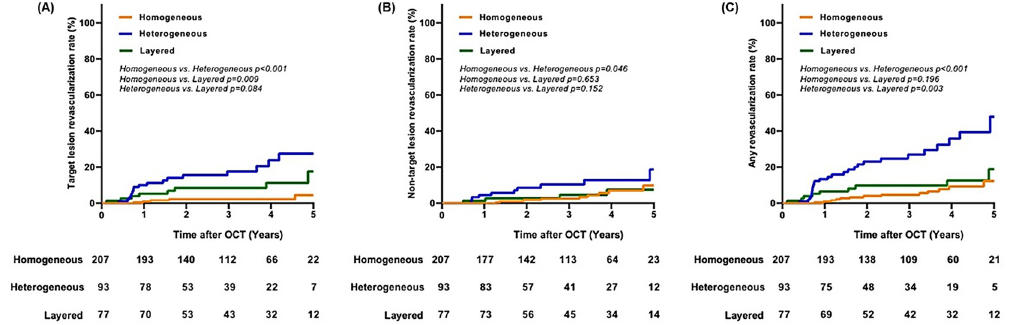
Fig 1. Kaplan-Meier curves for the target lesion revascularization rate (A), non-target lesion revascularization rate (B), and any revascularization rate (C) according to the neointimal characteristics. https://doi.org/10.1371/journal.pone.0247359.g001 2.9% vs. 19.4% vs. 10.4%, p < 0.001; Fig 1A). The heterogeneous neointima group showed sig- nificantly higher non-TLR rate than the homogeneous neointima group and tended to have higher non-TLR rates than the layered neointima group (homogeneous vs. heterogeneous intima: 8.7% vs. 14.0%, p = 0.046; heterogeneous vs. layered neointima: 14.0% vs. 7.8%, p = 0.152; Table 2, Fig 1B). The heterogeneous neointima group had significantly higher any revascularization rate than the homogeneous and layered neointima groups (homogeneous vs. heterogeneous intima: 10.6% vs. 30.1%, p < 0.001; heterogeneous vs. layered neointima: 30.1% vs. 13.0%, p = 0.003; Fig 1C). TLR (36.7%) and non-TLR (23.3%) were more frequently observed in the patients who underwent DCB angioplasty in the heterogeneous neointima group (Fig 2A and 2B). Subgroup analysis according to the reason for follow-up angiography was shown in S2 Table. The incidence of DCB angioplasty, heterogeneous neointima, any MI and TLR were sig- nificantly higher in group with an evidence of ischemia for follow-up angiography. However, there was no significant difference in the incidence of NTLR between group with an evidence of ischemia for follow-up angiography and routine follow-up angiography. Multivariate analysis showed that heterogeneous neointima (HR: 2.237, 95% confidence interval [CI]: 1.023–4.890, p = 0.044) and chronic kidney disease (hazard ratio [HR]: 8.730, 95% CI: 2.175–35.036, p = 0.002) independently increased the non-TLR incidence (Table 3). Heterogeneous neointima (HR: 2.671, 95% CI: 1.261–5.656, p = 0.010) and chronic kidney disease (HR: 5.971, 95% CI: 1.902–18.751, p = 0.002) were the independent predictors of any revascularization (Table 4). In addition, the significant predictor for the heterogeneous neoin- tima was MI at the time of OCT (HR: 6.698, 95% CI: 1.212–37.022, p = 0.029) (S3 Table).